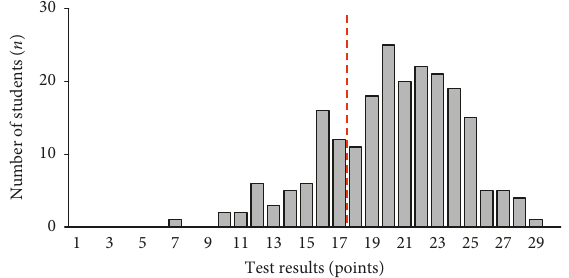
Figure 4: Distribution of points in the obligatory test of the complete test group (cohort 2+3). 3rd year medical students had to answer questions in pharmacology after a semester course of pharmacology ( n � 179). The dotted line marks the passing grade of 60%.